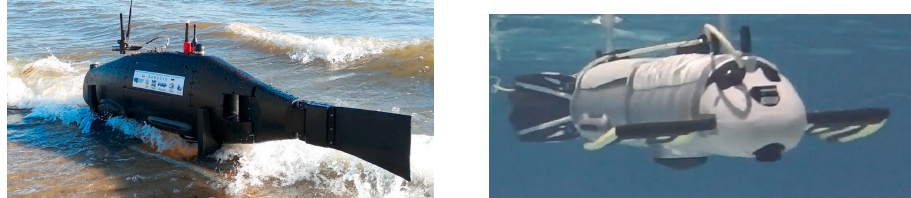
Figure 3. BAUV examples made at the Polish Naval Academy [own source]. Table 6. List of algorithms validated in numerical research between 2016 and